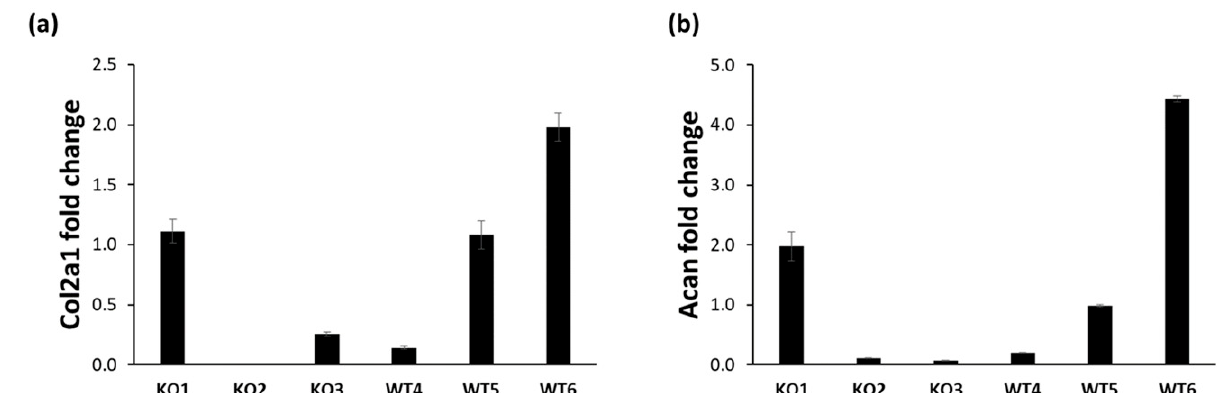
Figure 3. Expression of extracellular matrix proteins in immortalized chondrocytes. ( a ) The type II collagen (Col2a1) expression was assessed by real-time PCR. Fold change was calculated by ∆∆ Ct method using Gapdh as housekeeping gene and WT5 as reference sample random selected. Data are reported as mean ± standard deviation of three replicates. ( b ) The aggrecan (Acan) expression was assessed by real-time PCR. Fold change was calculated by ∆∆ Ct method using Gapdh as housekeeping gene and WT5 as reference sample random selected. Data are reported as mean ± standard deviation of three replicates. All samples expressed type II collagen and aggrecan, even if with a huge variability among cell lines.